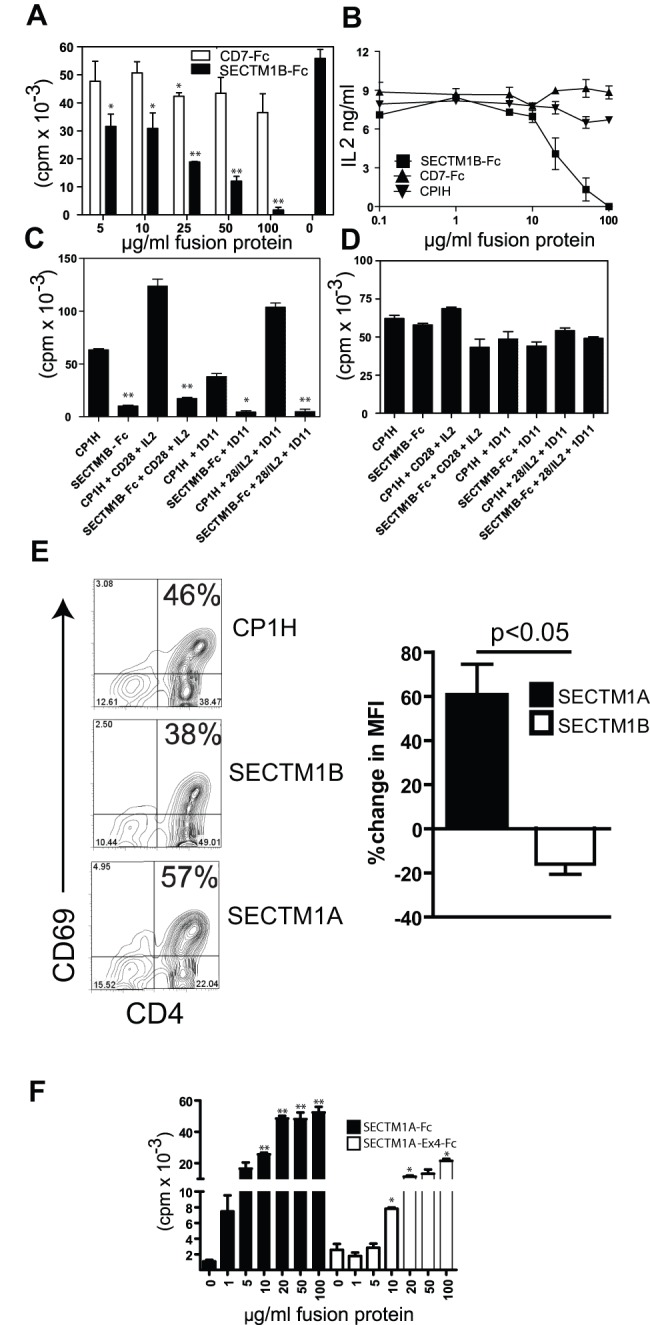
SECTM1A costimulates whereas SECTM1B inhibits T cell activation.A. 48+ T cells cultured on 2C11 coated plates in the presence of solid-phase mCD7-Fc or mSECTM1B-Fc fusion protein. Campath-1H antibody was used to equilibrate each well to an equal protein concentration. Results representative of five separate experiments. * = p<0.05, ** = p<0.005 by Student's t test. B. ELISA for IL-2 in supernatants of CBA/Ca CD4+ T cells stimulated for 48 hours in the presence of plate-bound 2C11 and solid phase SECTM1B-Fc, CD7-Fc or Campath-1H. Results are representative of three experiments. SECTM1B inhibition significant at 20,50 and 100 ug plated fusion protein assessed by Student's t test. C. Proliferation assay with CD4+ T cells cultured on 2C11 coated plates in the presence of solid-phase mSECTM1B-Fc fusion protein or Campath-1H as control. Anti-mCD28 or neutralising anti-TGFβ (1D11) was added to some wells at 1 ug/ml. Where indicated, IL-2 was added at 10 U/mL. * = p<0.05, ** = p<0.005 by Student's t test. Results are representative of two experiments. D. Proliferation assay with CD4+ T cells. The supernatants from the cell cultures described in ‘Figure C’ were added to fresh cultures of CBA.CA CD4+ T cells cultured with plate-bound 2C11. Proliferation was assessed at 48 hours. Results representative of two separate experiments. Differences not significant by Student's t test. E. Left panel; Cell surface expression of CD69 on CD4+ T cells (approximately 85% pure) cultured for 48 hours on 2C11(1 ug/ml) coated 96 well plates in the presence of plate-bound CP1H, SECTM1B-Fc or SECTM1A-Fc. All fusion proteins coated at 10 ug/ml. Results representative of three separate experiments. Right Panel; Pooled data from three experiments showing percentage change in CD69 on activated CD4+ T cells. Cells were cultured as above in the presence of 10 ug/ml plate bound fusion proteins and the percentage change in mean fluorescence intensity for CD69 above or below the CP1H control is shown. Statistical significance was measured using Student's T test. F. Proliferation assay with CD4+ T cells cultured on 2C11 coated plates in the presence of solid-phase mSECTM1A-Fc fusion protein or SECTM1A-ExIV-Fc. Proliferation was measured at 48 hours. Results representative of five separate experiments. * = p<0.05, ** = p<0.005 by Student's t test.